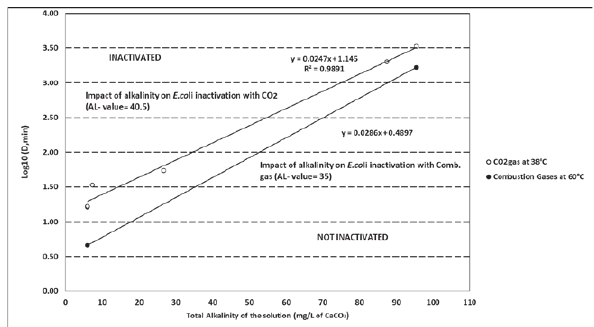
Figure 2. Minimum CO 2 bubbling times at diff erent alkalinity val- ues to achieve 1-log bacteria inactivation in 6 diff erent alkaline solutions. Above and to the right of the lines the pathogens will be sterilized by